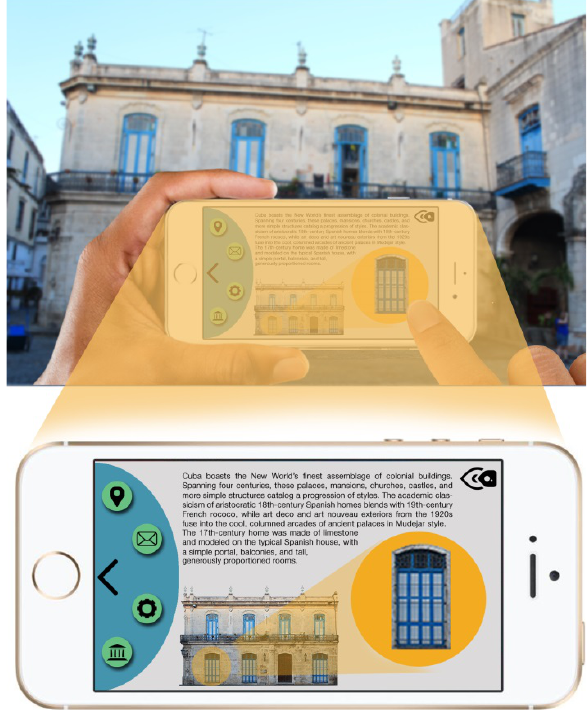
Figure 8. Example of an application of aumented reality (Casa de Baños - Plaza de la Catedral)